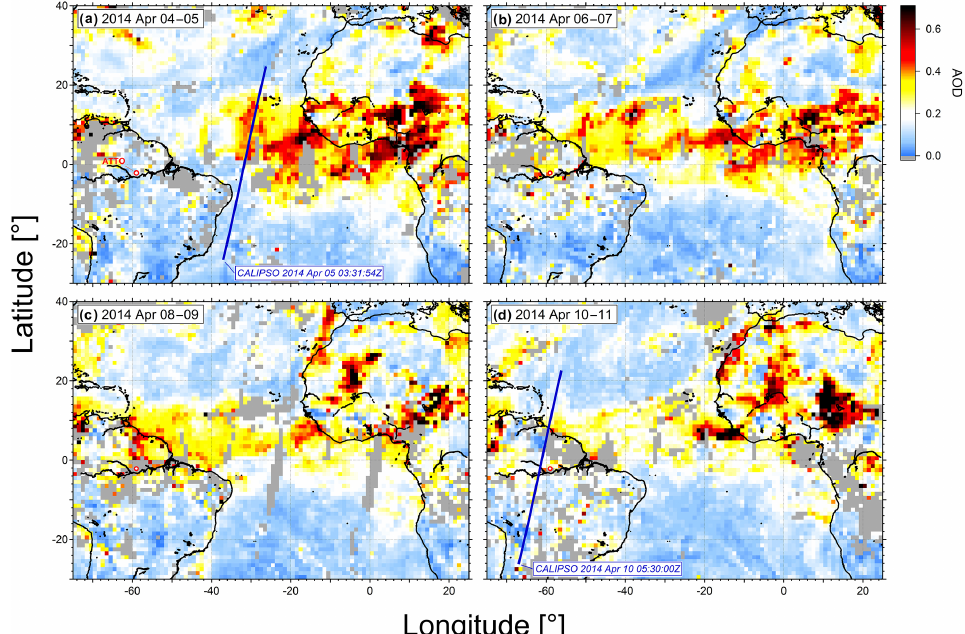
Figure 11. MODIS-derived AOD data showing Saharan dust outbreak, transatlantic passage, and intrusion into the Amazon Basin in the beginning of April 2014. Selected orbits of the CALIPSO spacecraft on 5 and 10 April are shown in (a, d) . Corresponding CALIOP lidar profiles transecting the dust plume are displayed in Fig. 12. The gray areas represent pixels with no satellite data for the corresponding time